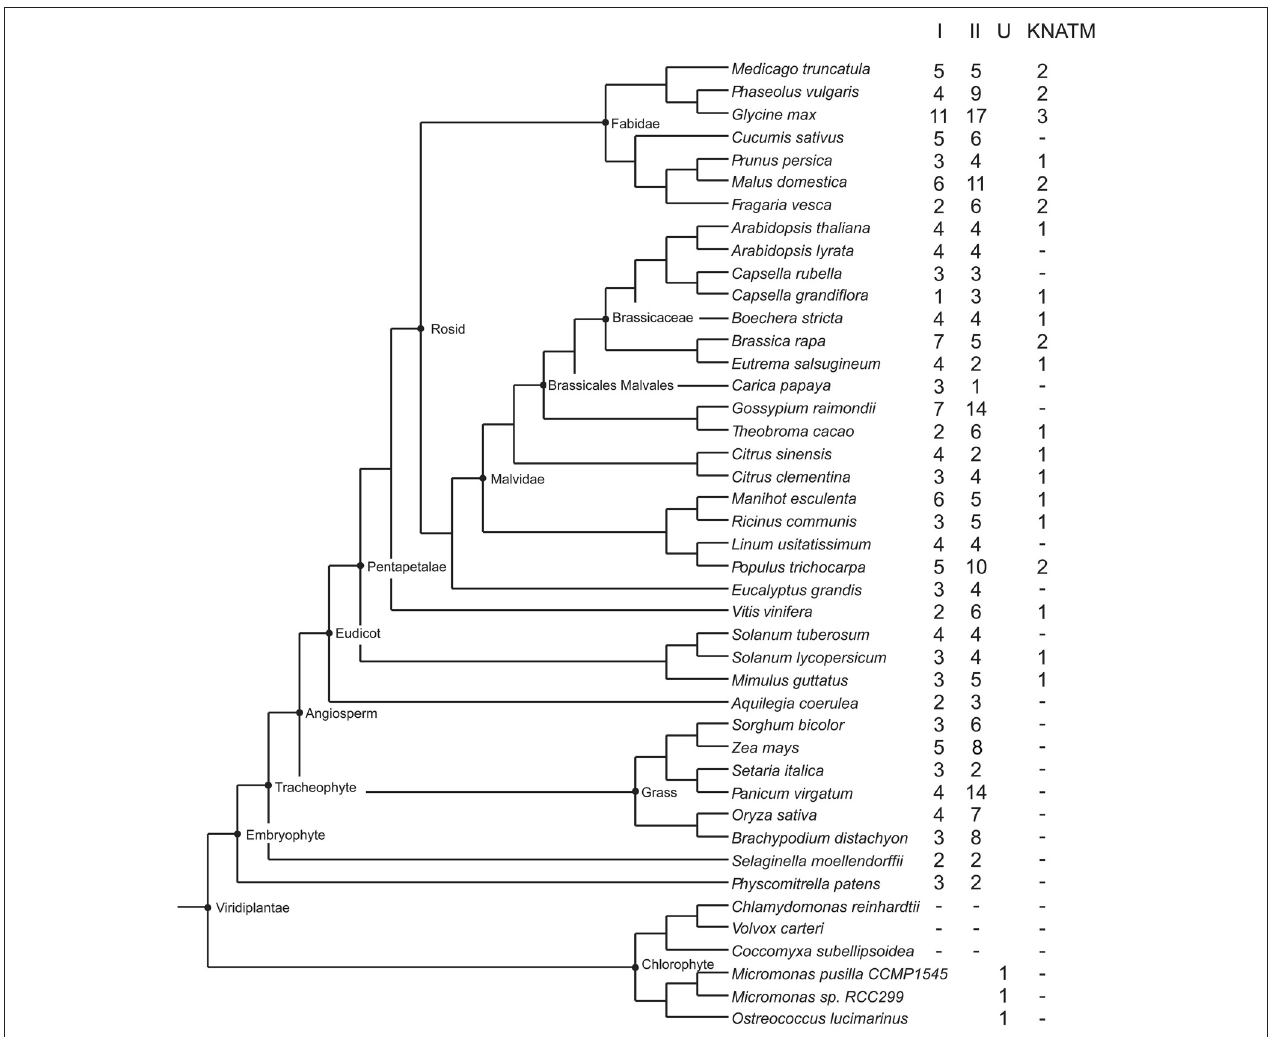
FIGURE 1 | Overview of plants and number of KNOX homologs. The schematic tree is based on the tree available at http://phytozome.jgi.doe.gov/pz/portal.html. Columns show number of homologs identified being members of class I, class II, unclassified (green algae), and KNATM, respectively.